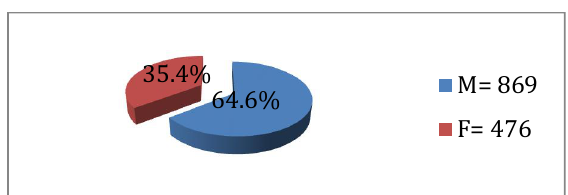
Figure 1. Gender